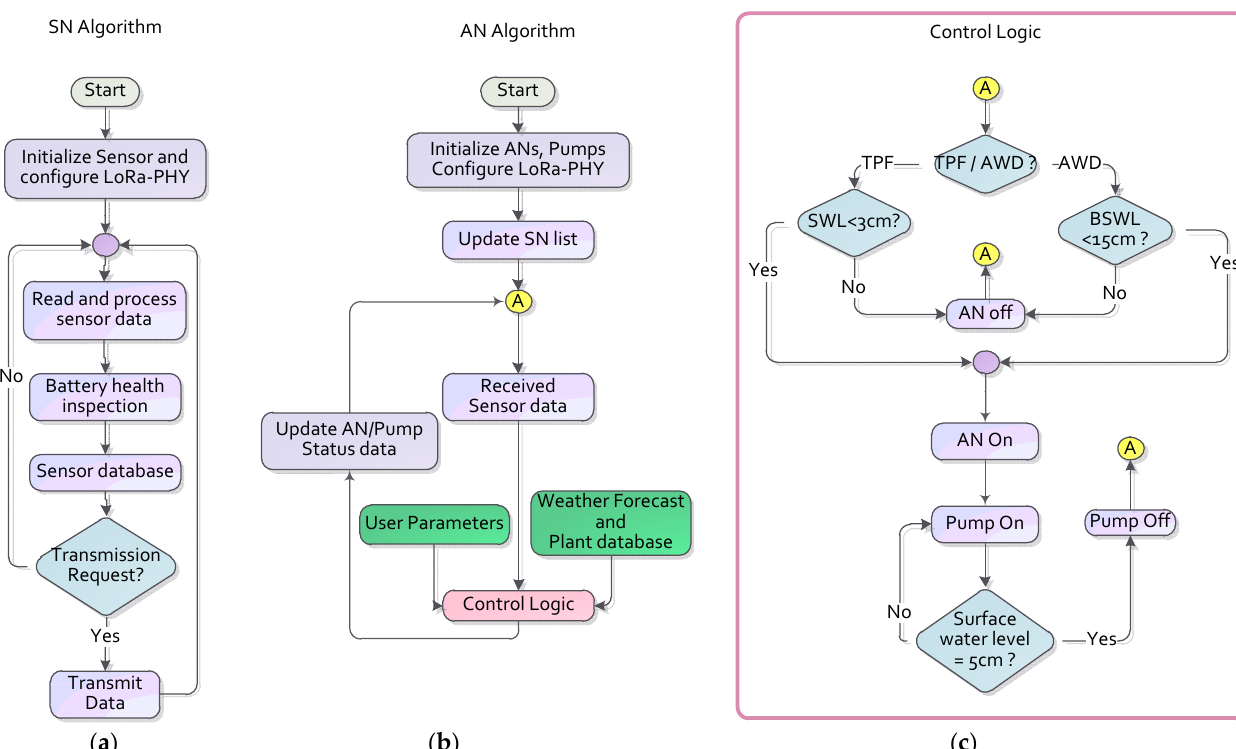
Figure 8. ( a ) Sensor node software algorithm used for field trial, ( b ) Proposed actuator node algorithm, and ( c ) Control logic algorithm for the AWD server intended for wide-area AWD automation.